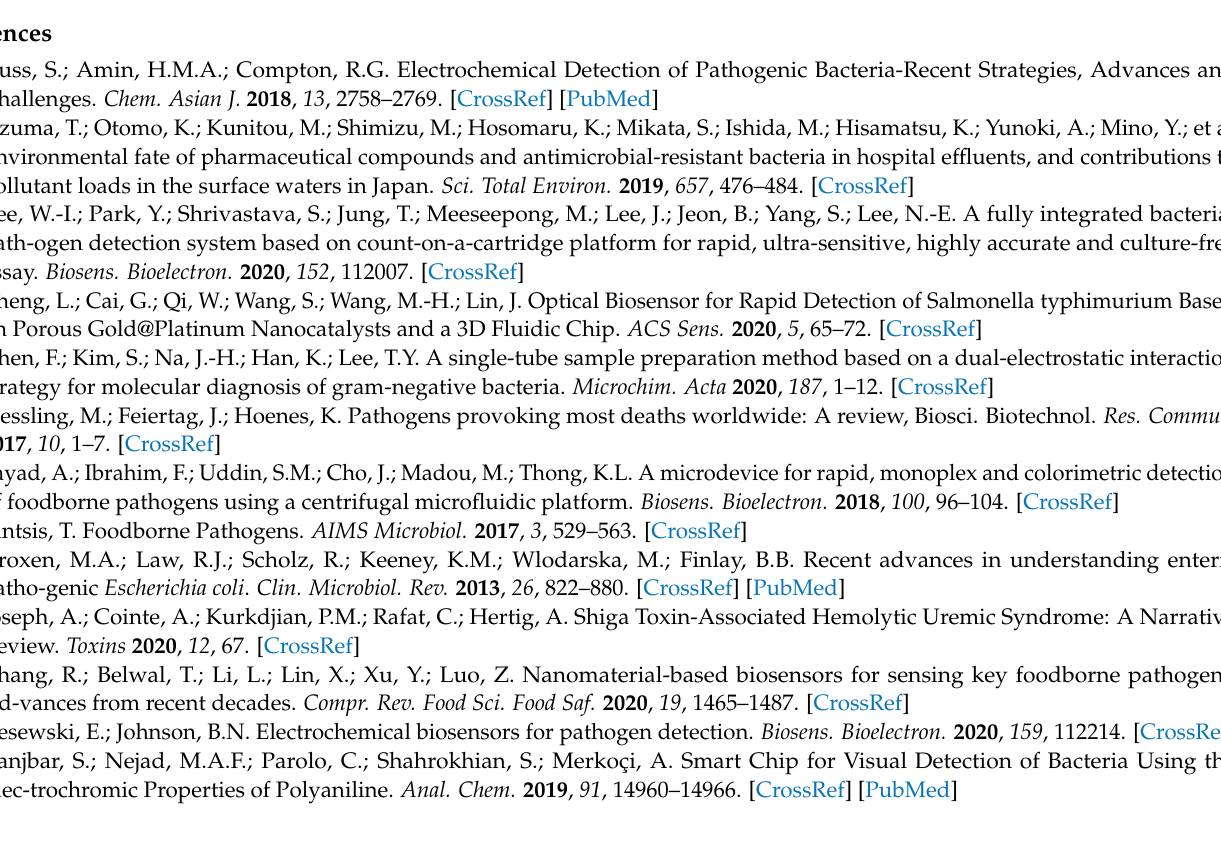
composites; Figure S5: Powder XRD pattern of MoS 2 –PANI composites; Figure S6: CV spectra of